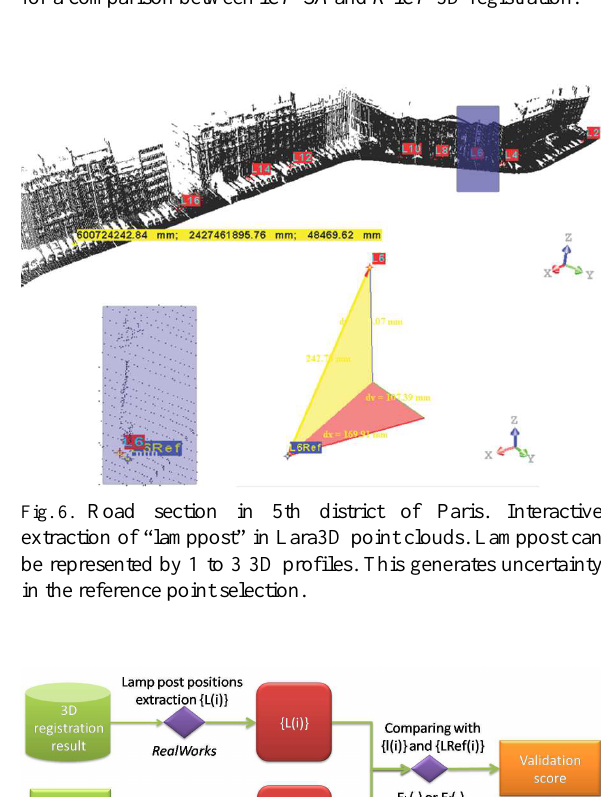
Fig. 5. 2D reference map (scale 1/200e) for the 5 th district area in Paris around the Pantheon . Different geometric features can be found in the 2D presentation with accurate positioning.